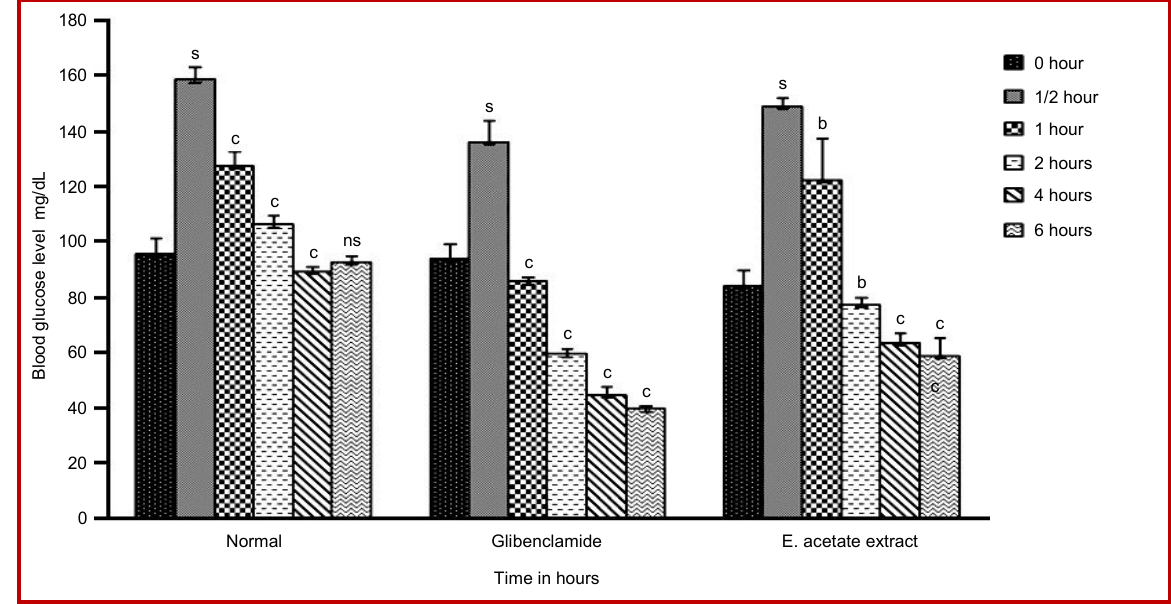
Figure 4: Oral glucose tolerance test (OGTT) of ethyl acetate extract of Teucrium stocksianum in normal rabbits. (n = 6) where, ns = Non significant change; b p<0.01; c p<0.001; s = significant increase (p<0.001) as compared to 0